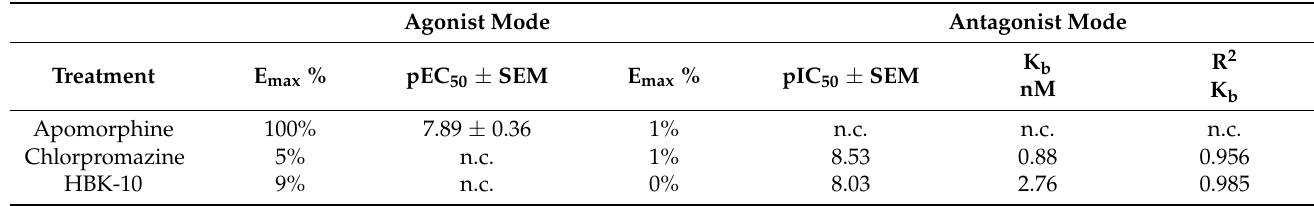
Figure 4. The effect of HBK-10 on the immobility of mice in the forced swim test (Panel ( A )) and on the behavior of mice in the tail suspension test (Panel ( B )). The tested compound or vehicle (1% Tween) were administered 30 min intraperito- neally ( ip ) before the test. The results are presented as box plots showing the following data: mean (‘+’), median (horizontal line), upper and lower quartile (the width of the box shows interquartile range), upper and lower extreme (whiskers). Statistical analysis: Shapiro–Wilk test for normality, Brown–Forsythe test for homogeneity of variance, and one-way ANOVA (Newman–Keuls post hoc); * p < 0.05, ** p < 0.01, **** p < 0.0001; n = 8–9 mice per group.